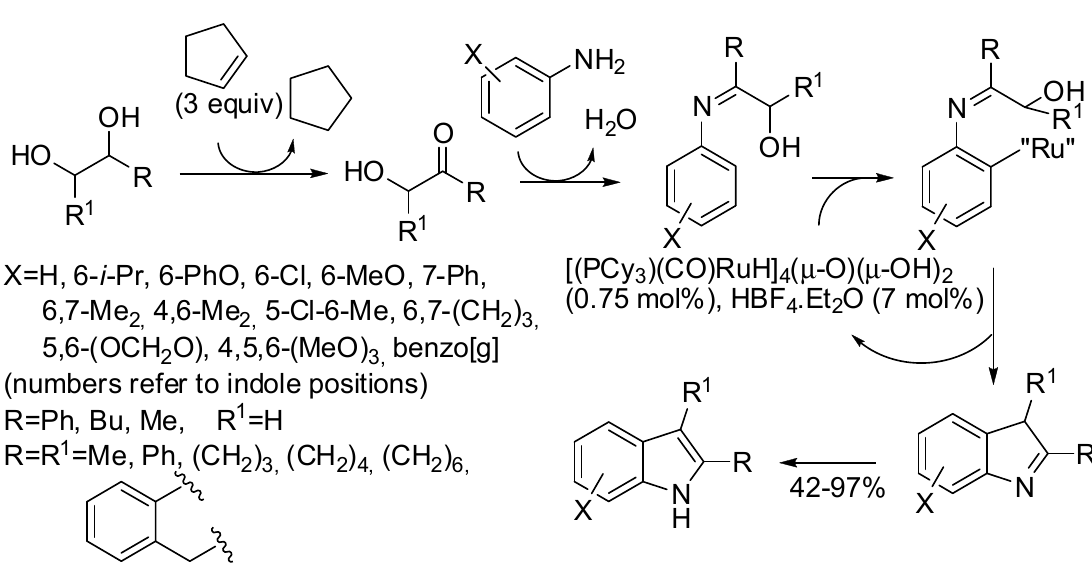
Scheme 67. Ruthenium-catalyzed dehydrative C − H coupling of arylamines with 1,2-diols. Another ruthenium catalyzed reaction was the cycloisomerization between enamides and silylalkynes (Scheme 68) [134]. Only a well-defined ruthenium hydride gave the 2,3-disubstitued indole, which was prepared in situ by reaction of a Grubbs II catalyst and trimethylsilylenol. Then camphor sulfuric acid (+)-CSA allowed the aromatization of the indoline. However, the amount of CSA has to be tested in each